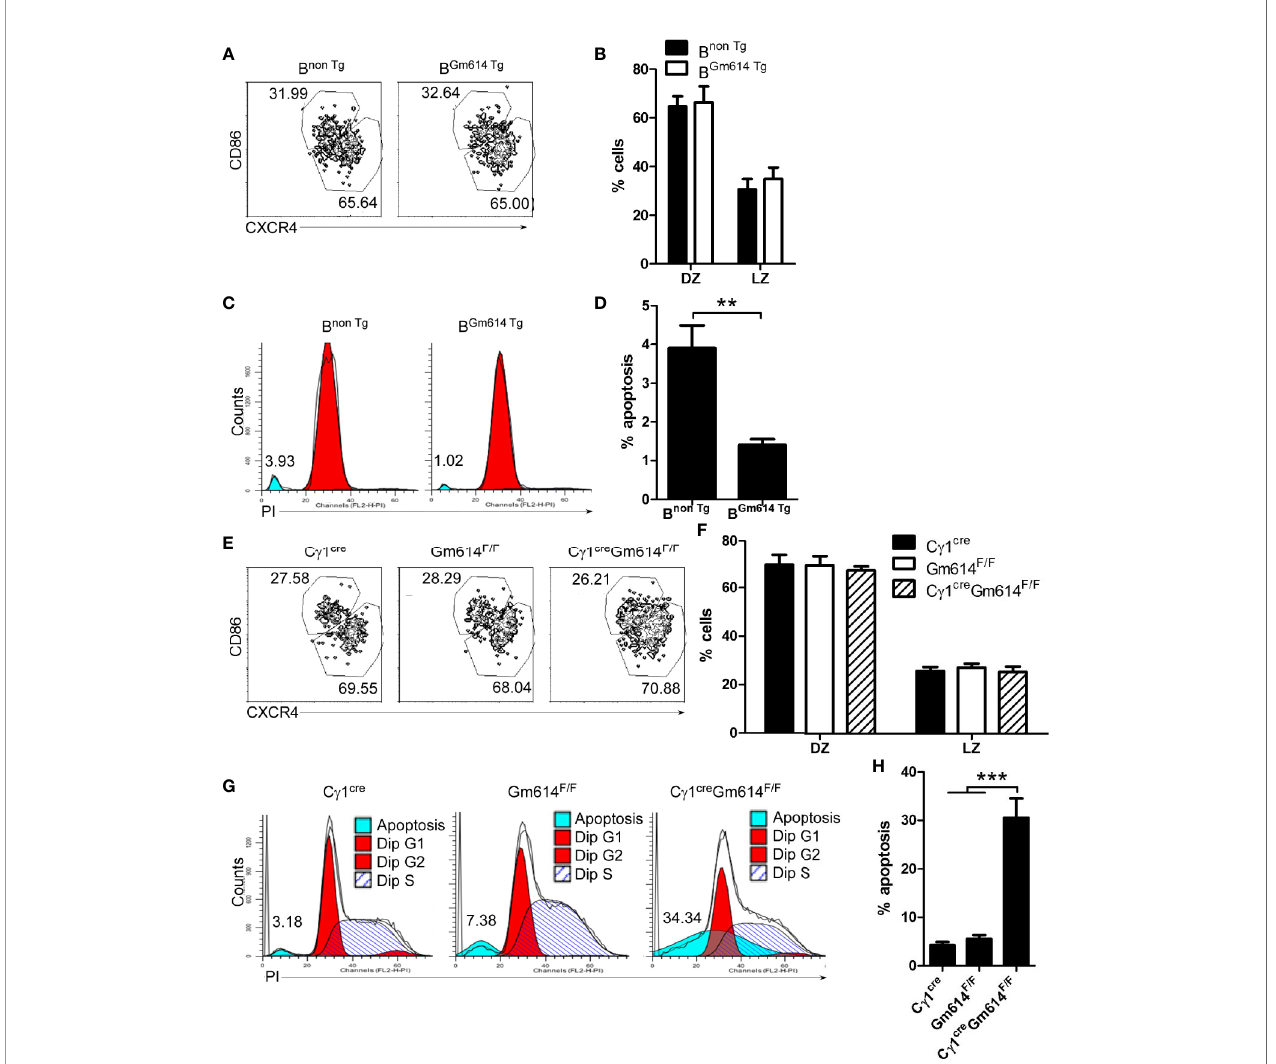
FIGURE 4 | Gm614 suppressed GC B cell death. Nine-week-old B non Tg and B Gm614 Tg (A – D) , or C g 1 cre , Gm614 F/F , and C g 1 cre Gm614 F/F (E – H) mice were i.p. injected with 0.5 ml pristane and analyzed 6 months after injection. (A, B) Gm614 Tg did not affect the percentages of B cells in dark zone (DZ) and light zone (LZ). On gated CD19 + B220 + CD38 lo GL7 hi GC B cells, CD86 lo CXCR4 hi DZ and CD86 hi CXCR4 lo LZ B cells were analyzed by FACS. The percentages of splenic DZ and LZ B cells (A) and their statistical analysis (B) are shown. (C, D) Gm614 Tg suppressed GC B cell death. Splenic CD19 + B220 + CD38 lo GL7 hi GC B cells were sorted by FACS and stained with PI (Propidium). The percentages of dead cells (C) and their statistical analysis (D) are shown. (E, F) Gm614 cKO did not affect the percentages of B cells in DZ and LZ. On gated CD19 + B220 + CD38 lo GL7 hi GC B cells, CD86 lo CXCR4 hi DZ and CD86 hi CXCR4 lo LZ B cells were analyzed by FACS. The percentages of splenic DZ and LZ B cells (E) and their statistical analysis (F) are shown. (G, H) Gm614 cKO promoted GC B cell death. Splenic CD19 + B220 + CD38 lo GL7 hi GC B cells were sorted by FACS and stained with PI. The percentages of dead cells (G) and their statistical analysis (H) are shown. (A – H) Data represent three independent experiments, with six samples per group per experiment. Two-Way (B, F) and One-Way (H) ANOVA was followed by Bonferroni post-tests and two tailed Student ’ s t-test (D) , Error bars, s.e.m., **p < 0.01, ***p < (Figure 7D) , anti-KLH IgM, IgG, and IgG1 antibodies (Figure 7E) induced by KLH. These results suggest that Gm614 cKO